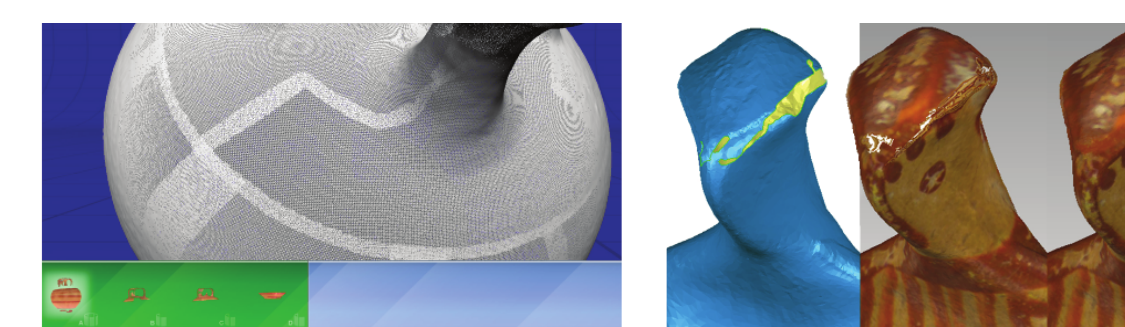
Figure 9. Model of stirrup jar after all families have been aligned and overlapping meshes largely reduced